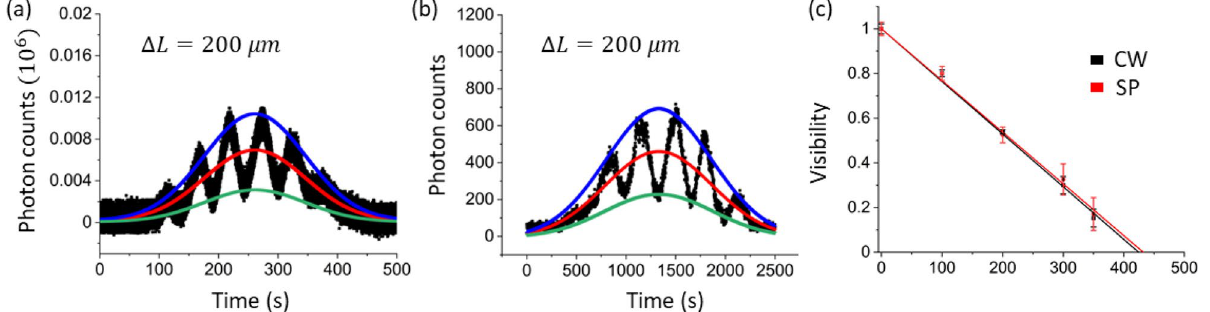
Figure 5. Visibility analysis for Fig. 4. ( a ) cw and ( b ) single photons for � L = 200 µ m . Blue: maximum, Green: minimum, Red: average. ( c ) Best-fit lines for calculated visibilities in Table 1. Red/black: single photon/coherent light. Standard deviation σ for � L = 200 µ m : 0.009 (cw), 0.035 (single photon). The best-fit Gaussian curves and error bars are generated using Origin. For details, see Figures. S4 and S5, and Table S2 of the Supplementary Information. SP—single photon. CW—continuous